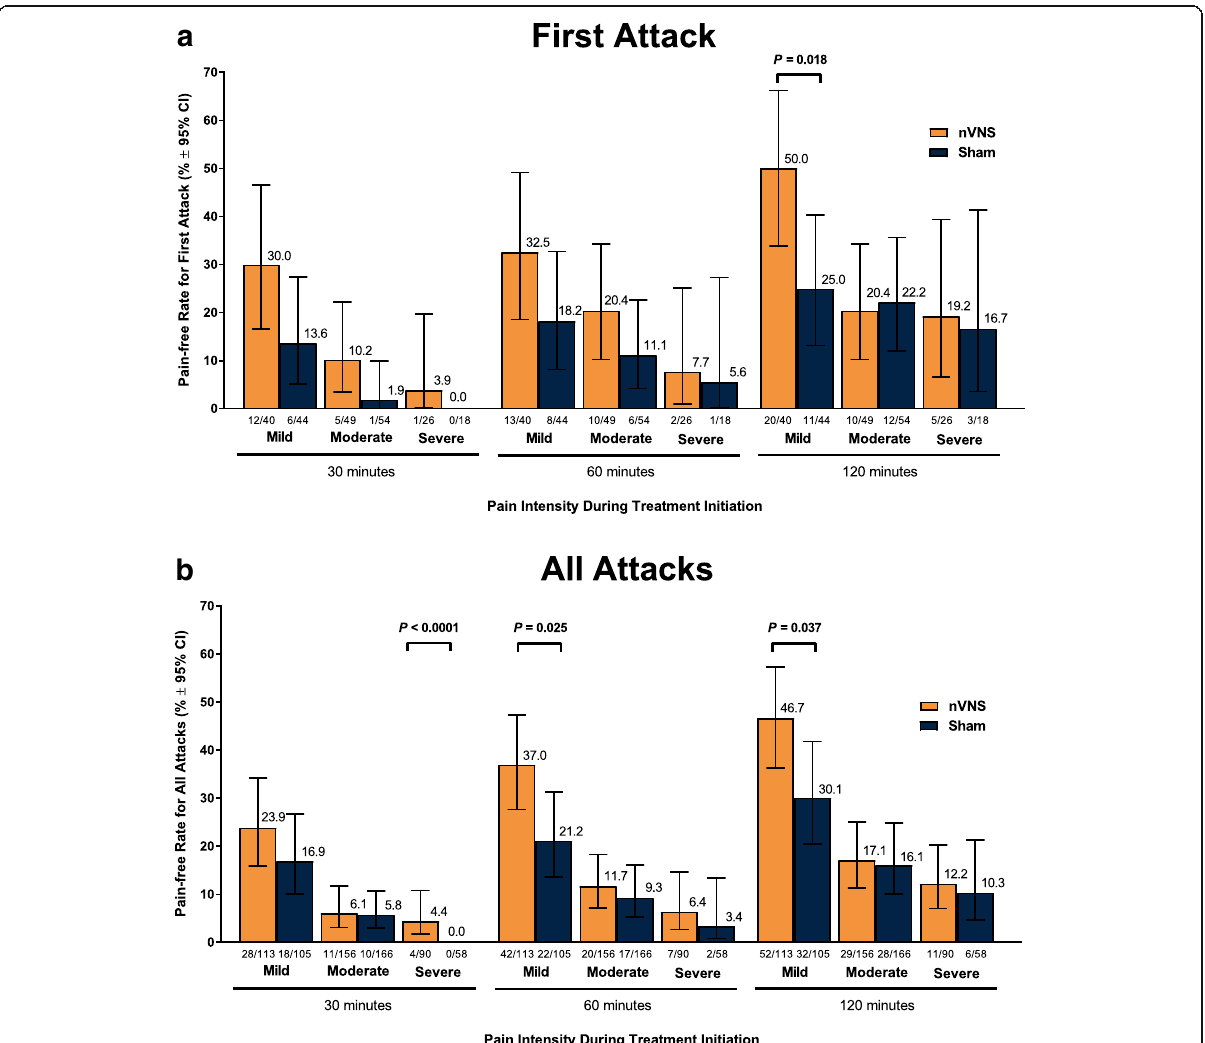
Fig. 5 Pain-free Rates at 30, 60, and 120 Minutes for ( a ) First Attack and ( b ) All Attacks. Abbreviation: nVNS, non-invasive vagus nerve